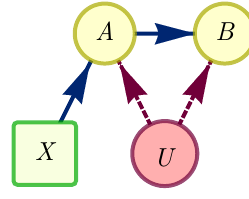
Figure 4: The instrumental scenario. (Not a correlation